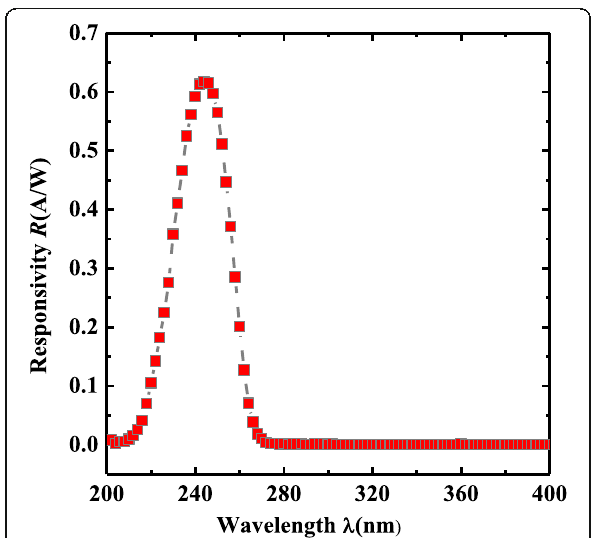
Fig. 6 Responsivity versus wavelengths for the PEDOT:PSS/Ga 2 O 3 hybrid photodetectors at V bias =-1.2